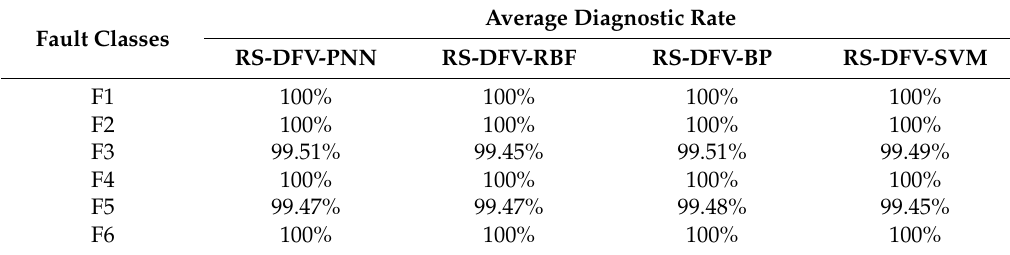
Table 13. Comparison with different classification